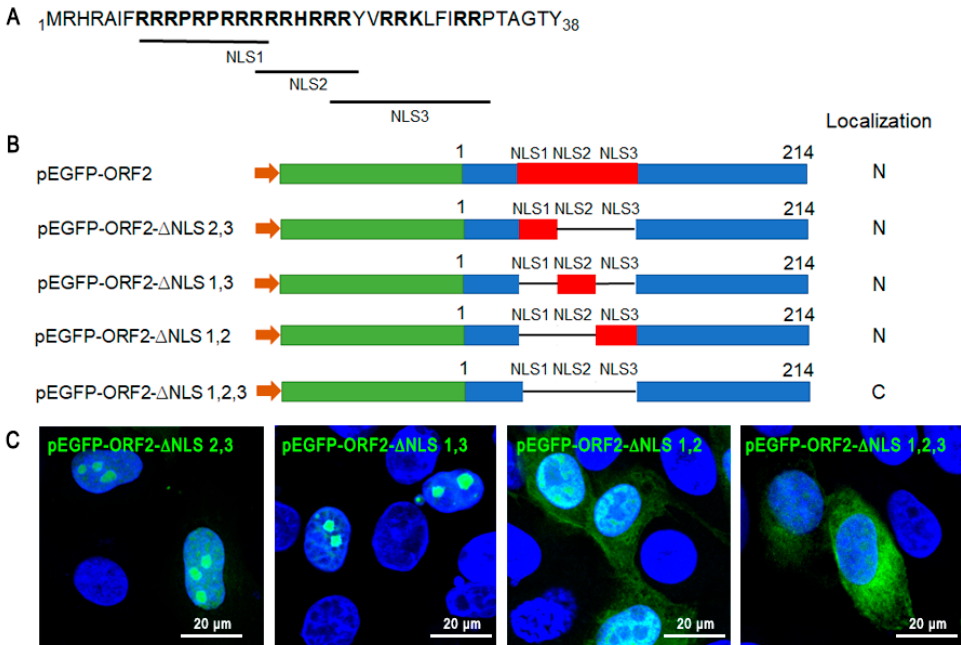
Figure 5. The map of NLSs in ORF2. ( A ) The main motifs of the NLSs in the N-terminal ORF2 (1–38 aa) are bold and the three NLSs are listed. ( B ) A sketch of the ORF2 indicating putative NLSs motifs by red boxes is shown, and the mutated fragments of the ORF2 are shown. ( C ) PK-15 cells were transfected with plasmids carrying mutated ORF2 gene (pEGFP-ORF2- ∆ NLS 2,3, pEGFP-ORF2- ∆ NLS 1,2, pEGFP-ORF2- ∆ NLS 1,3, and pEGFP-ORF2- ∆ NLS 1,2,3) to analyze their subcellular location. Subcellular localization of green fusion proteins was analyzed by confocal microscopy. Scale bars = 20 μ m.